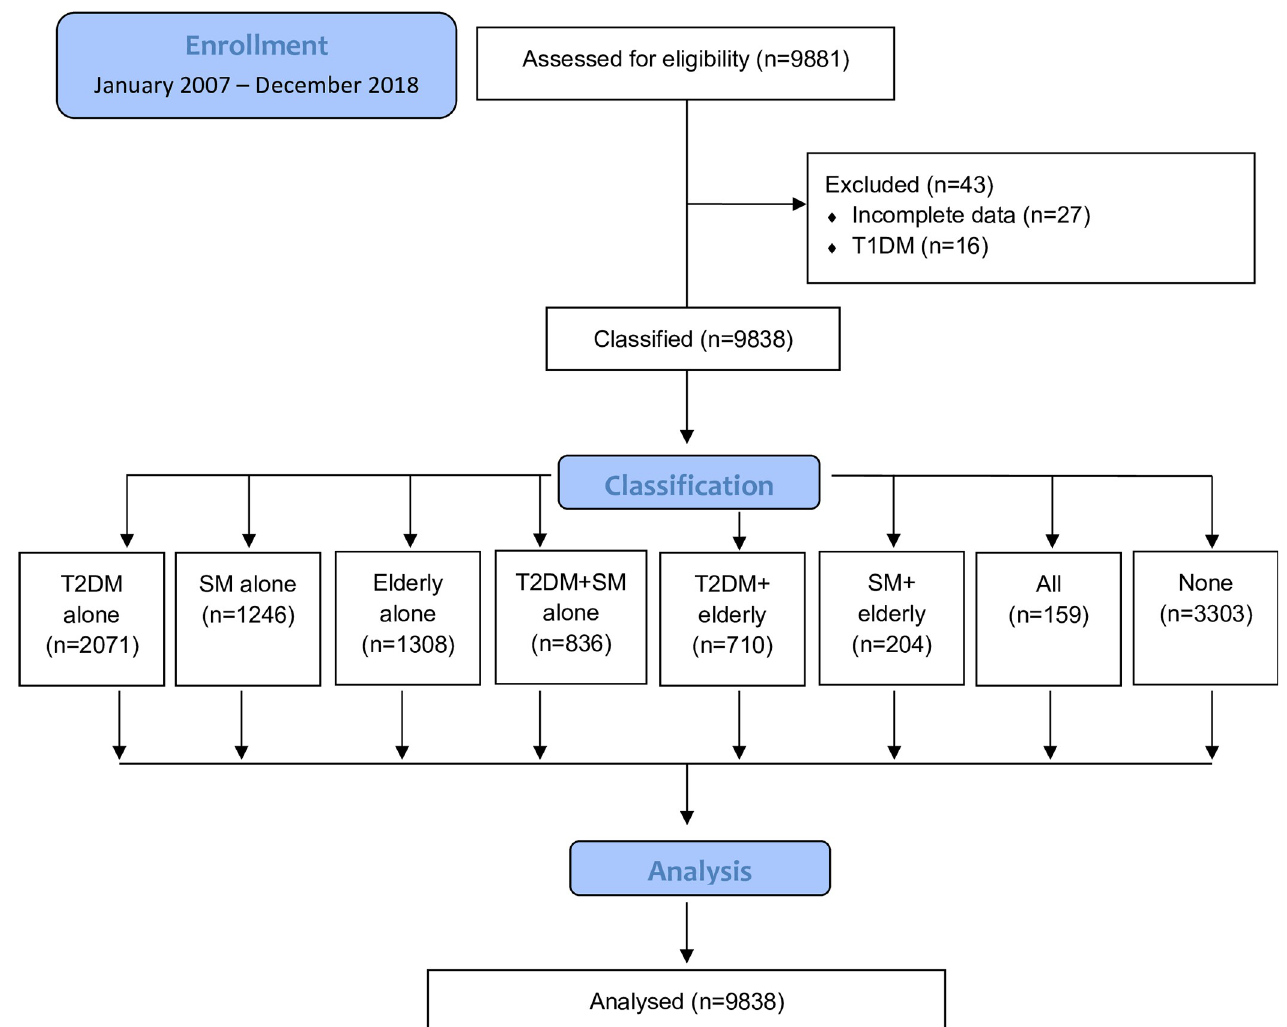
Fig 1. Consort flowchart. Group allocation ana analyses of cardiac surgery patients with diabetes mellitus only (T2DM alone), smoking (SM alone), and aging (Elderly alone). Groups containing pairwise (T2DM + SM, T2DM + Elderly, and SM + Elderly) and concomitant combination (“All”) significant factors were also separated. “None” denotes no occurrence of these risk factors. The total of 9881 patients were enrolled in the study period. Forty-three patients were excluded from the data set due to incomplete registration of the anthropometric outcomes and/or blood sample analyses (n = 27), or subsequent to the diagnosis of type 1 diabetes (n = 16). As a result, 9838 cardiac surgery patients were included in the